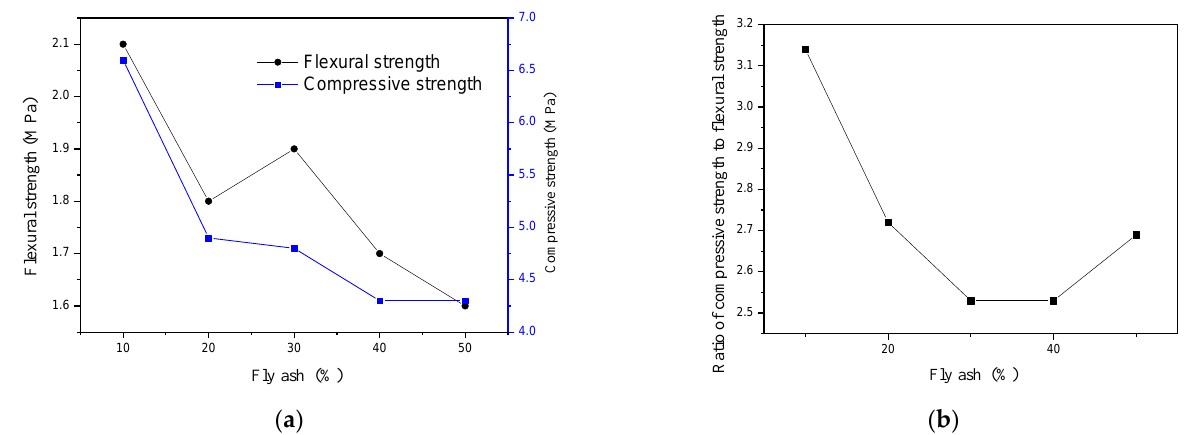
Figure 5. Influence of fly ash on the mechanical properties of mortars: ( a ) flexural strength and compressive strength, ( b ) ratio of compressive strength and flexural strength.